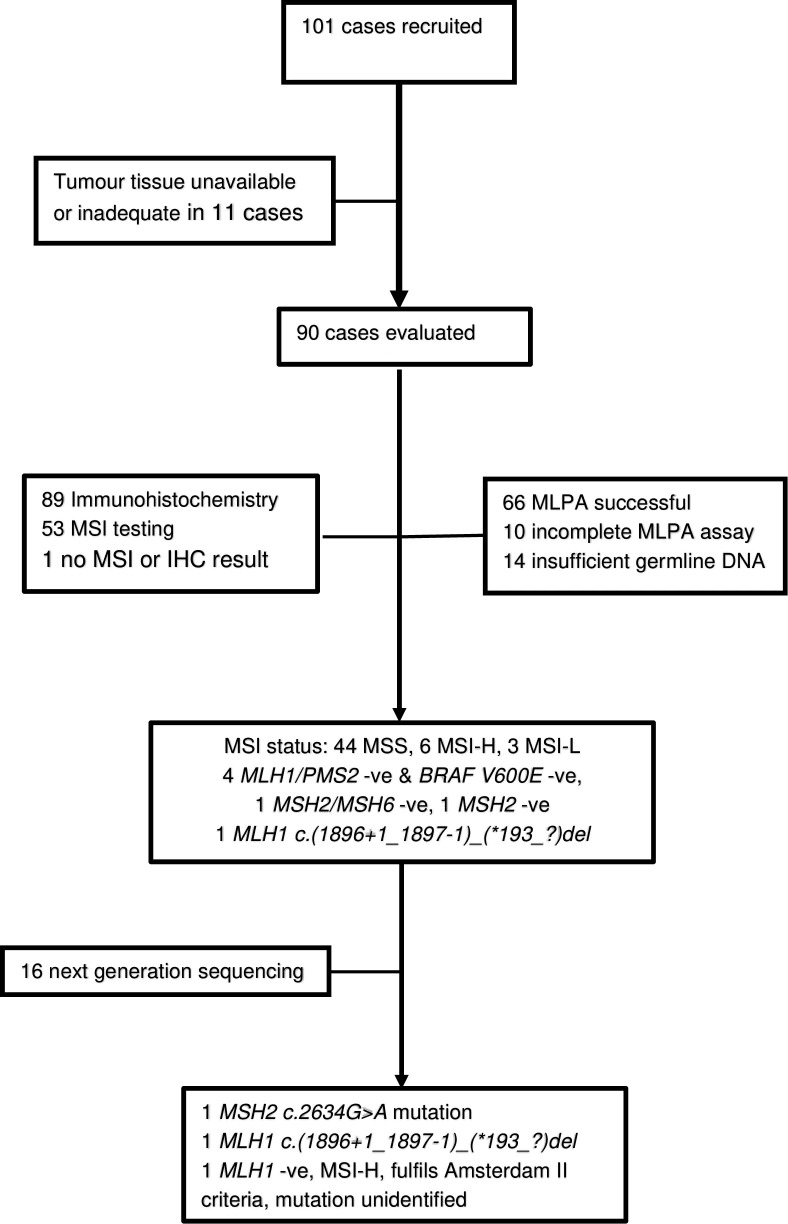
Study flowchart describing the laboratory process for evaluating cases for inherited colorectal cancer (-ve–negative).